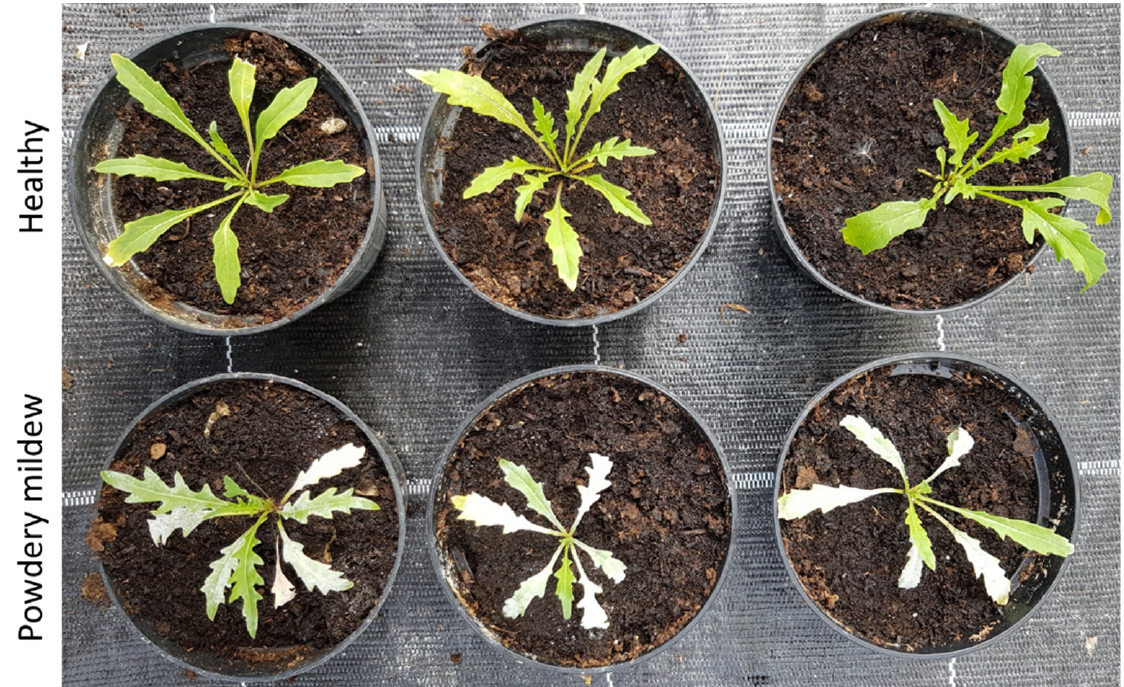
Figure 3. Healthy and powdery mildew-infected wild rocket.